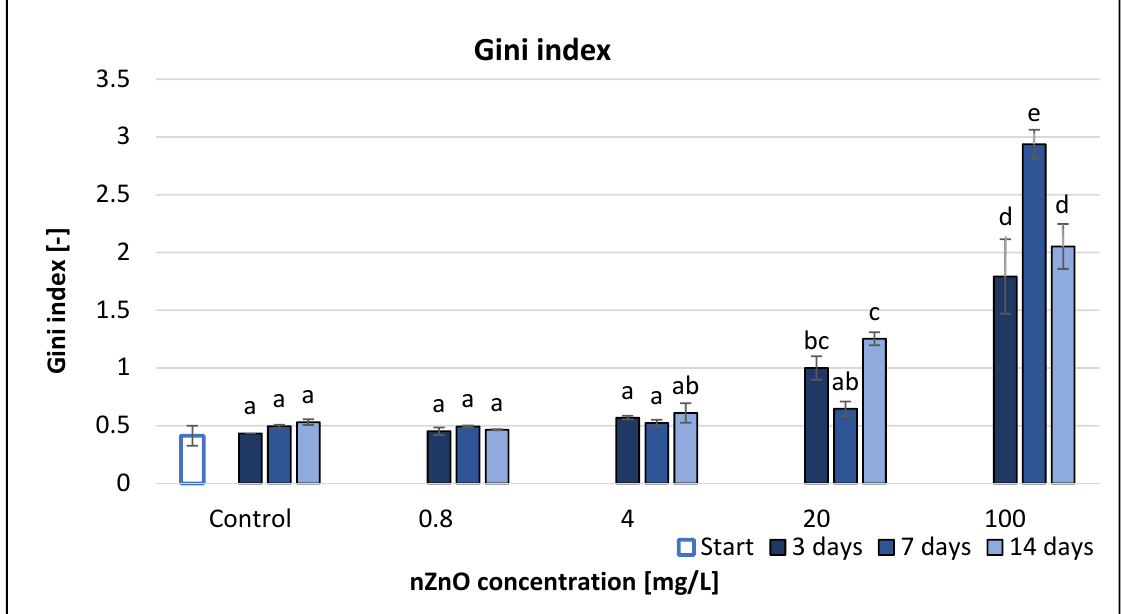
Figure 8. The effect of ZnO nanoparticles on freshwater Gini index value. Letters on the columns indicate significant differences (level of significance: p < 0.05).